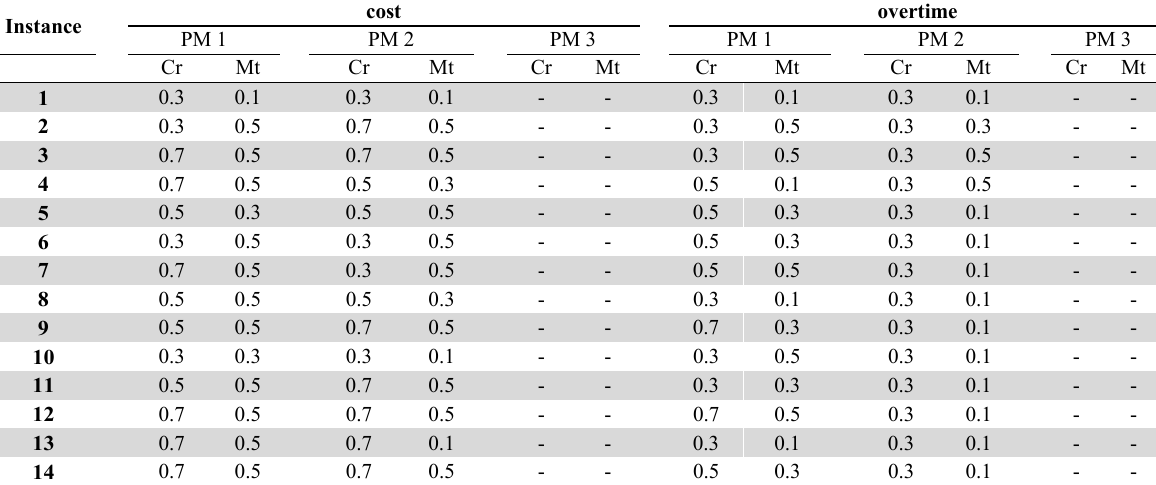
Values of parameters guaranteeing best solution